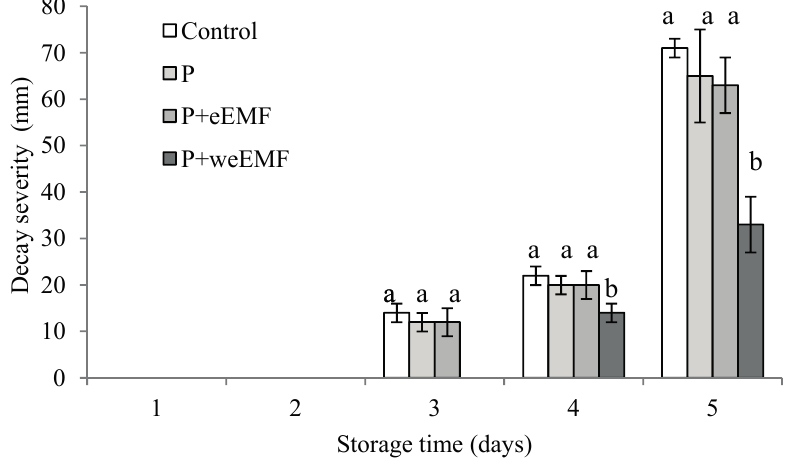
Figure 2. Effect of pullulan coating with or without incorporated meadowsweet flower extract on decay severity of peppers inoculated with R. arrhizus spores during 5 days at simulated marketing conditions (24 °C, RH 55%–60%). The severity of decay was expressed as the mean lesion diameter of pepper